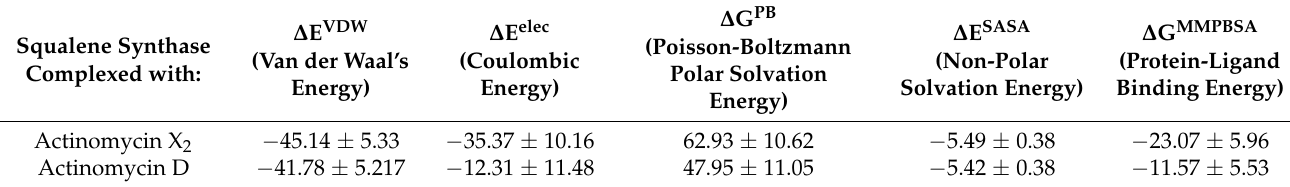
Table 5. MMPBSA binding energy in kcal/mol for the protein-ligand